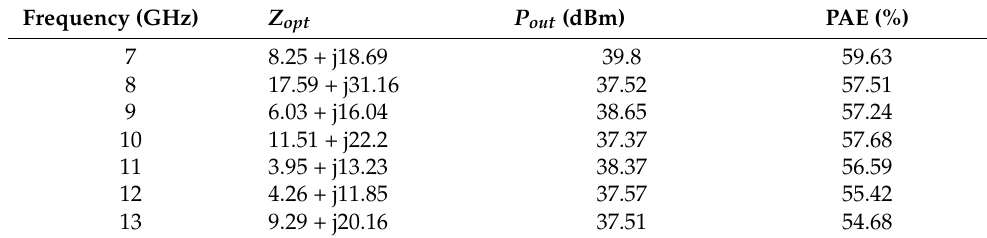
Figure 5. Load – pull contours for 𝑃 𝑜𝑢𝑡 and PAE from 7 to 13 GHz and ideal load impedance. Figure 5. Load–pull contours for P out and PAE from 7 to 13 GHz and ideal load impedance. Table 2. Load – pull simulation result of two parallel HEMTs. Table 2. Load–pull simulation result of two parallel HEMTs.